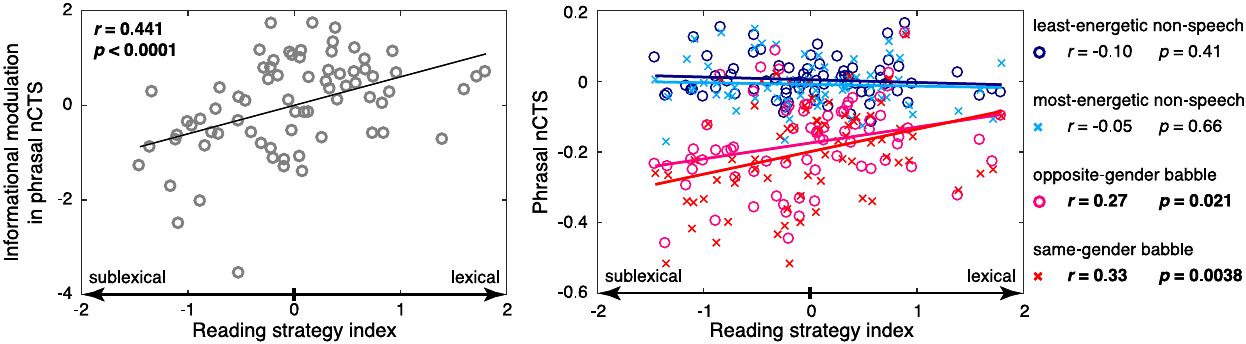
Fig 3. Relation between the reading strategy index and the nCTS at phrasal rate. Left—the informational modulation in phrasal nCTS as a function of the reading strategy index. Gray circles depict participants’ values, and a black trace is the regression line, with correlation and significance values indicated in the top-left corner. Right—the mean nCTS across visual conditions and both hemispheres for the four types of noise: least-energetic nonspeech (blue circles), most-energetic nonspeech (turquoise crosses), opposite-gender babble (red circles), and same-gender babble (pink crosses). Circles and crosses depict participants’ values, and full traces are the regression lines. Correlation and significance level for all noise conditions are indicated on the right of each plot. S3 Data contains the underlying data for this figure. nCTS, normalized cortical tracking of speech.